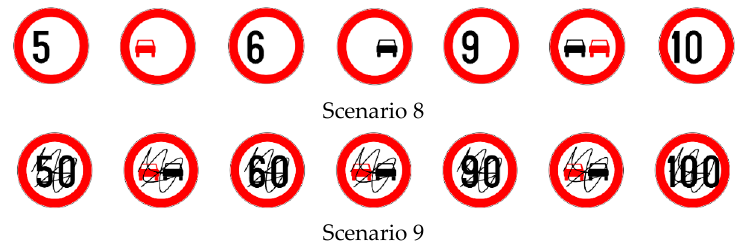
Figure 2. Visual presentation of signs used in each scenario.